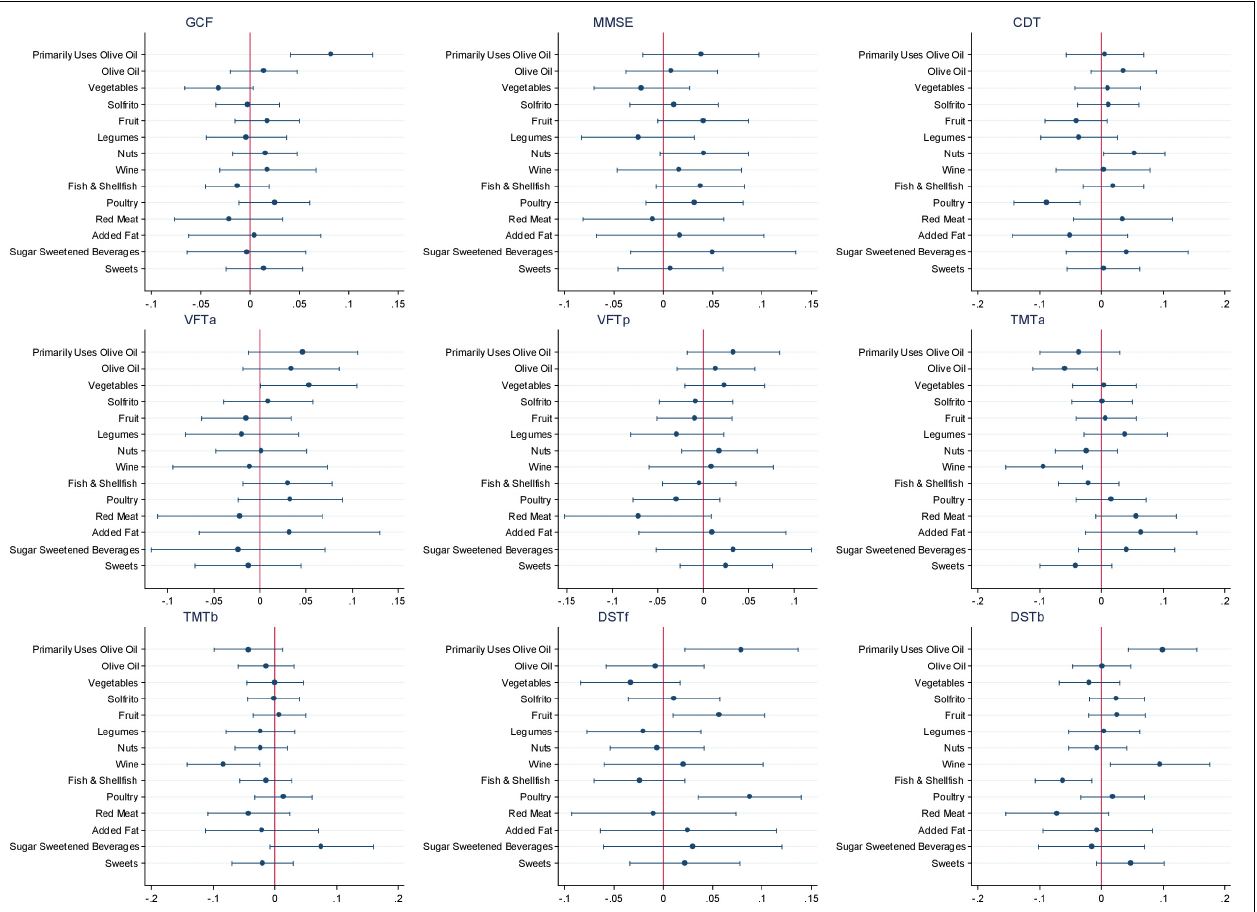
FIGURE 3 | Association of specific dietary components of the Mediterranean dietary pattern (MedDiet) on the cognitive function battery of tests. CDT; clock drawing test; DST-b, digit span test backward; DST-f, digit span test forward; GCF, global cognitive function; MMSE, Mini-Mental State Examination; TMT-A, Trail Making Test Part A; TMT-B, Trail Making Test Part B; VFT-a; verbal fluency tasks semantical; VFT-b; verbal fluency tasks